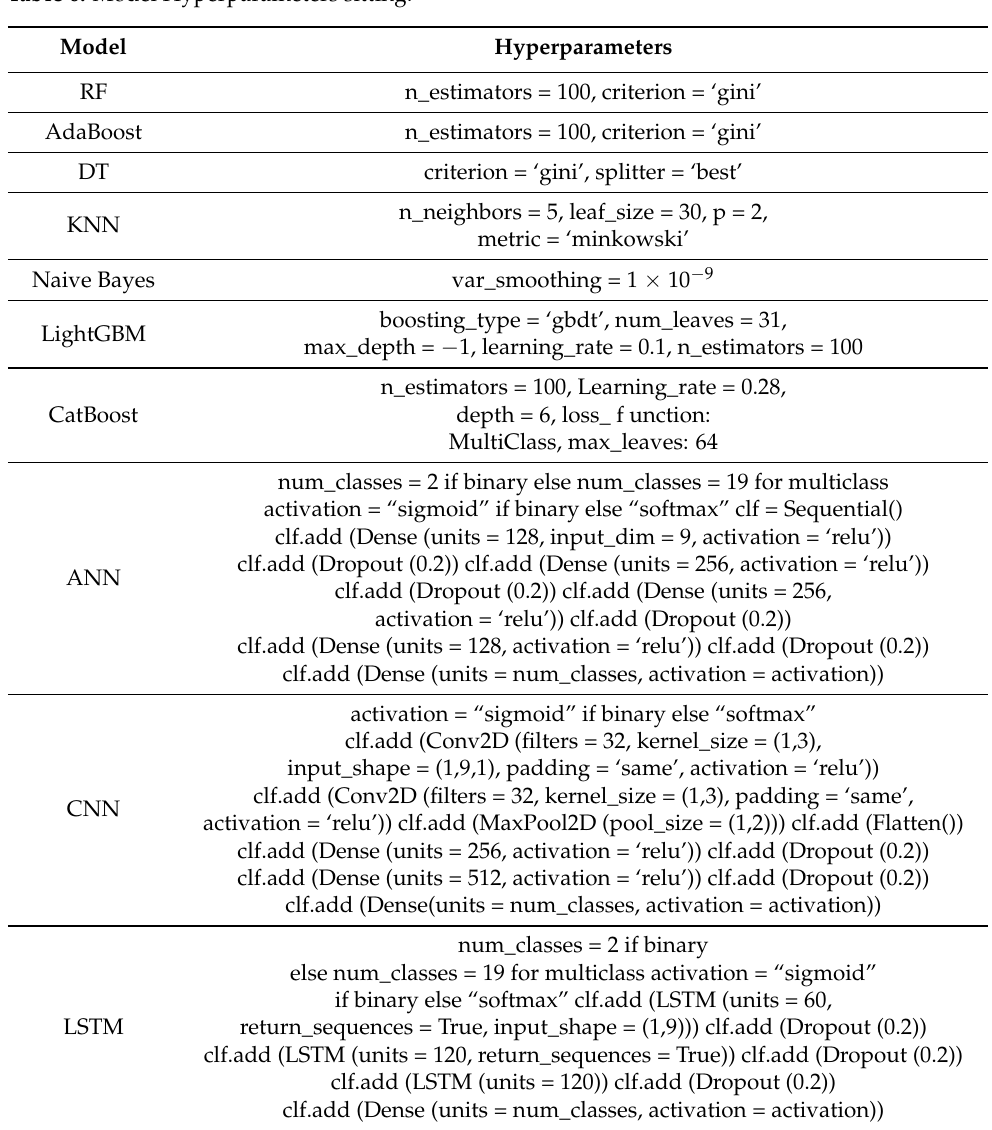
Table 6. Model Hyperparameters